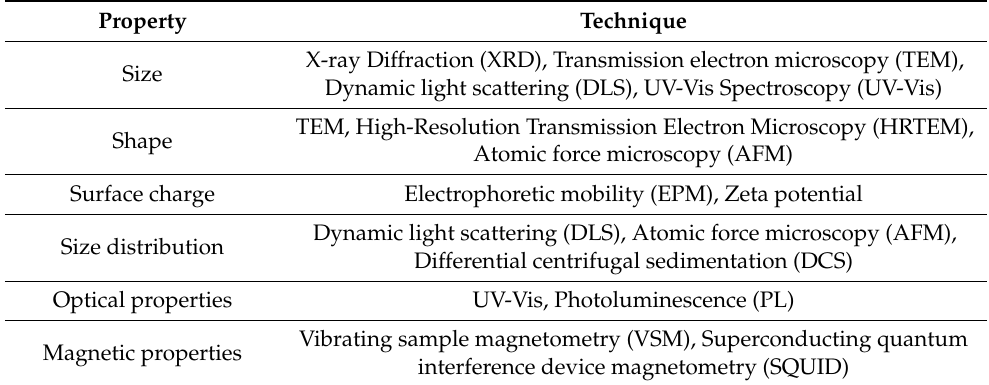
Table 1. Nanoparticle characterization